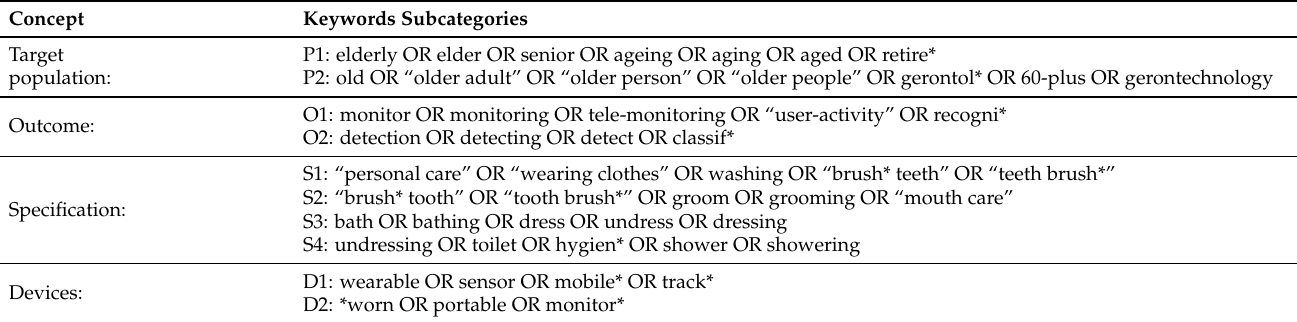
Table A3. Subcategories of Keywords applied in ACM. An asterisk (*) was used as a wildcard to broaden the search for words starting or ending with a